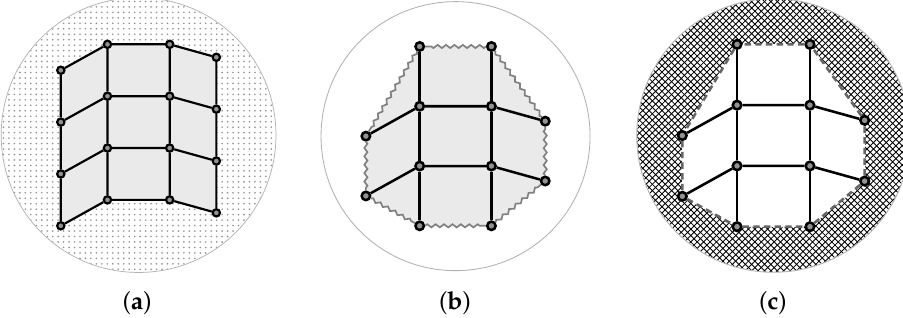
Figure 63. Figure ( a ) depicts a block and hole polyhedron P consisting only of blocks. Figure ( b ) shows the graph G M ( P ) (in which degree two vertices have been removed), and ( c ) depicts the graph G S ( P ) of the swapped polyhedron. This graph can also be viewed as a pinned graph. Figures by Elissa Ross, used with permission [107].